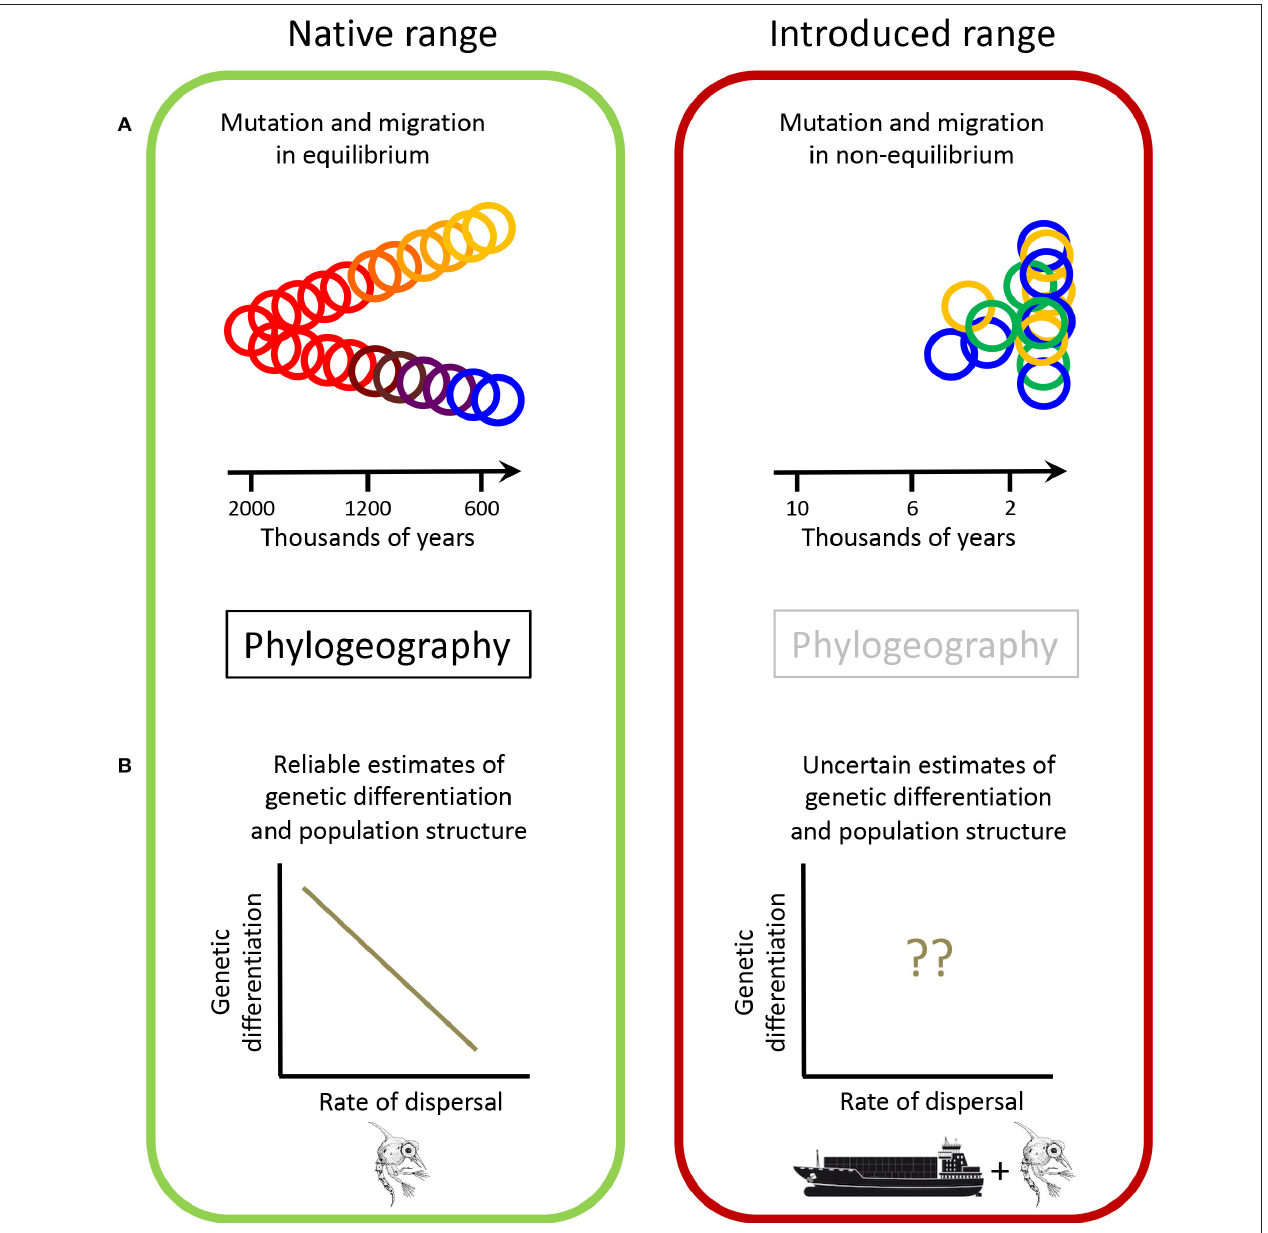
FIGURE 1 | The use of phylogeography to study the geographic ordination of genotypes in native and introduced ranges. The main differences are highlighted considering: (A) Different evolutionary histories and (B) Population structure patterns found in the different range types. The time scale in (A) reflects that most studies of phylogeography focus on the Quaternary period (Beheregaray, 2008). Regarding the introduced range, although humans began navigating the seas ∼ 50,000 years ago (Broome, 1994) and domestication of animals and plants saw its onset 13,000 years ago (Diamond, 1998), most non-indigenous species introductions have occurred in recent times (Carlton, 2009). The green circles (A) indicate admixed genotypes (see details in text). The decapod crustacean zoeae larva (from Weiss, 2017) in (B) represents the natural dispersal capabilities of species, while the ship tanker (from: www.shutterstock.com/image-vector/cargo-vessels-tugboat-oil- platform-isolated-239670235) denotes human-mediated transport of